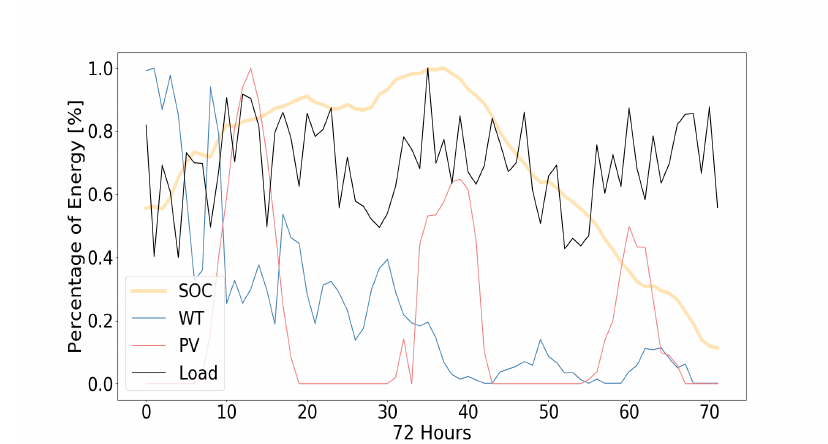
Figure 5. Scenario 4: SOC of batteries vs. load, and wind/irradiance resources